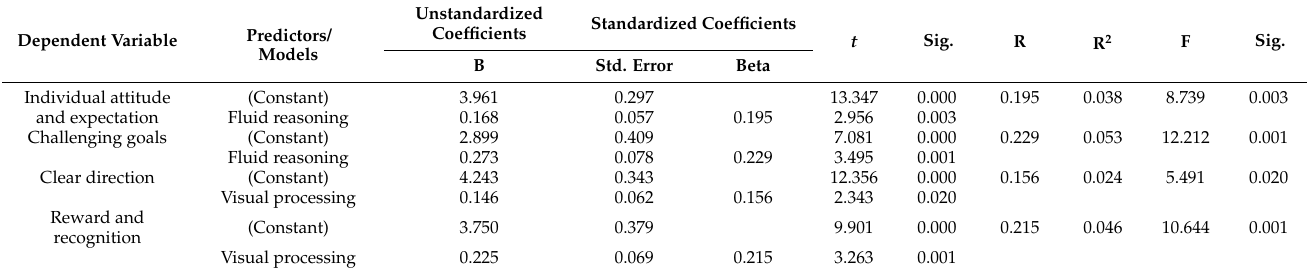
Table 10. Multiple linear regression models in the group of non-participants of computer programming courses, the dependent variables are learning motivating factors, and the predictors are self-reported cognitive abilities. Dependent